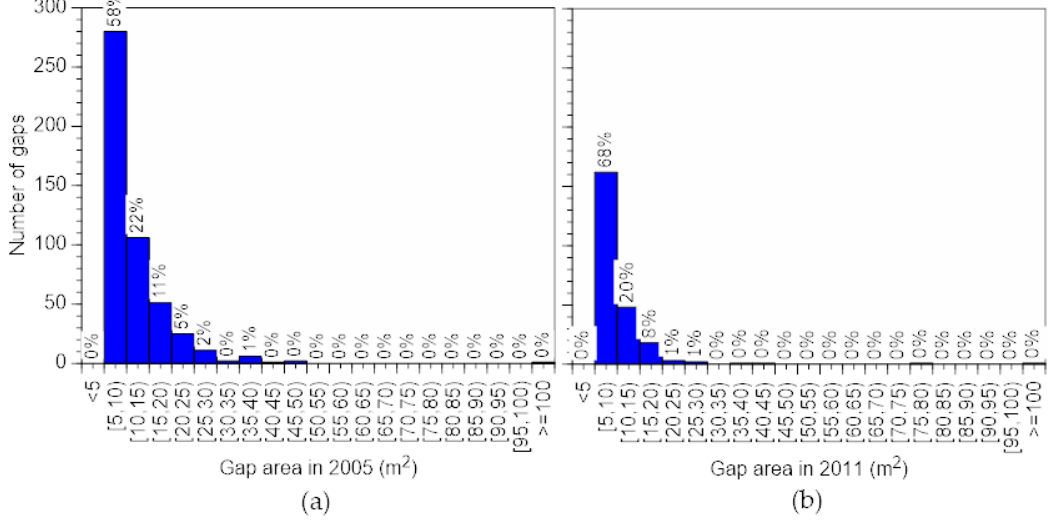
Figure 7. Number of gap closures by area class. Gap closures ( a ) between 2005 and 2011 (period A) and ( b ) between 2011 and 2016 (period B).